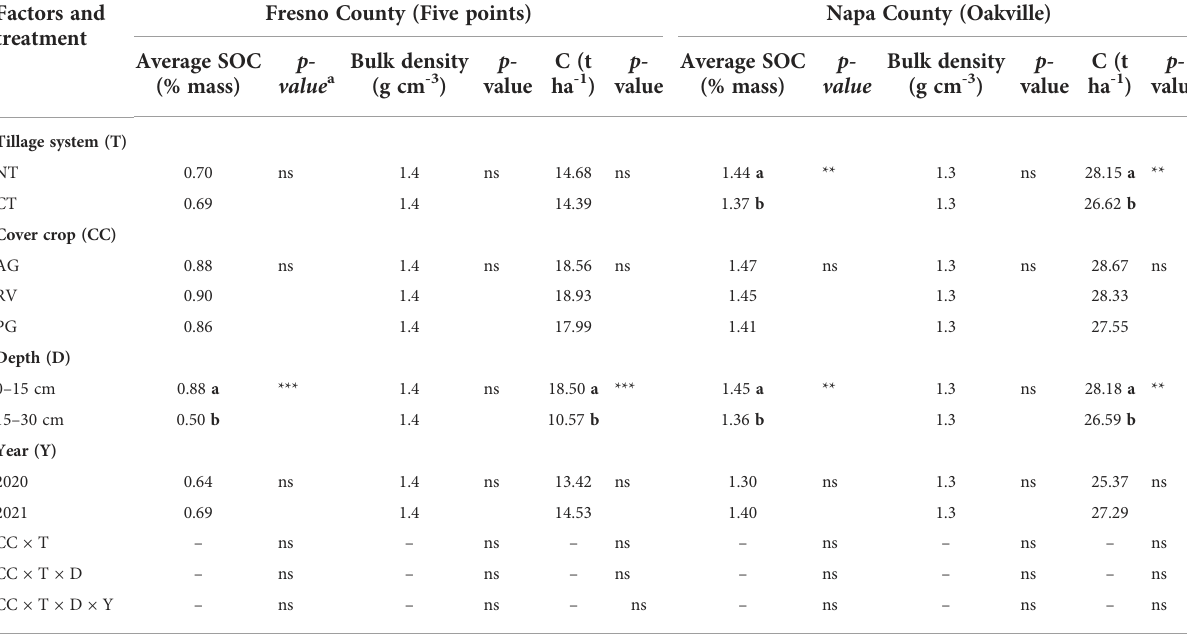
TABLE 2 Soil organic carbon (% by mass), bulk density (g cm -3 ), and total C (Mg ha -1 ) in Fresno County and Napa County. Factors and